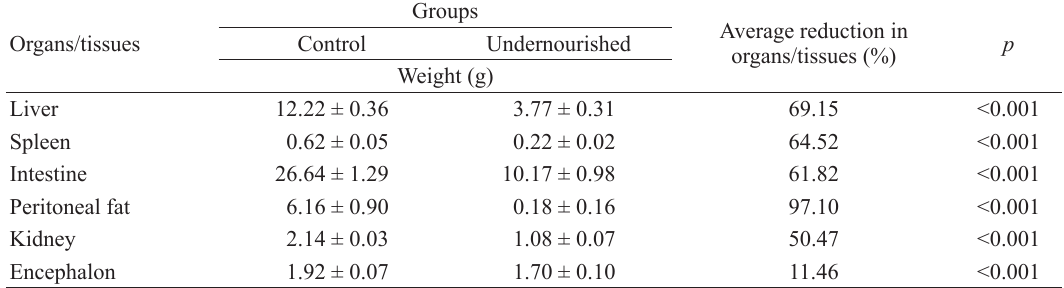
Weight reduction of the organs and peritoneal fat (in grams) of rats submitted to caloric restriction.